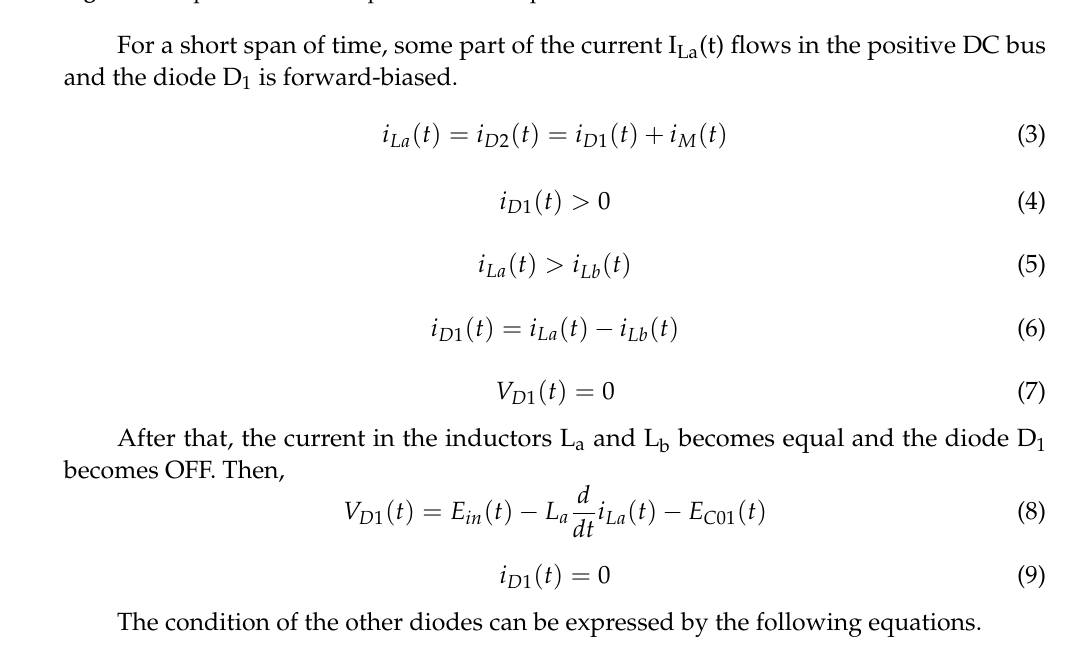
Figure 2. Proposed MVR with positive current path and closed switch.